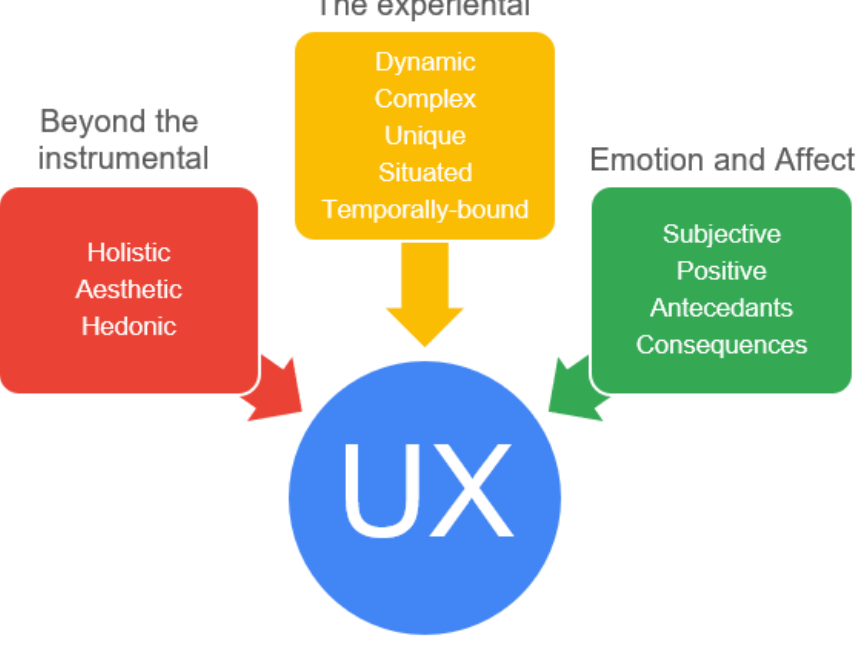
Figure 5. Facets of the